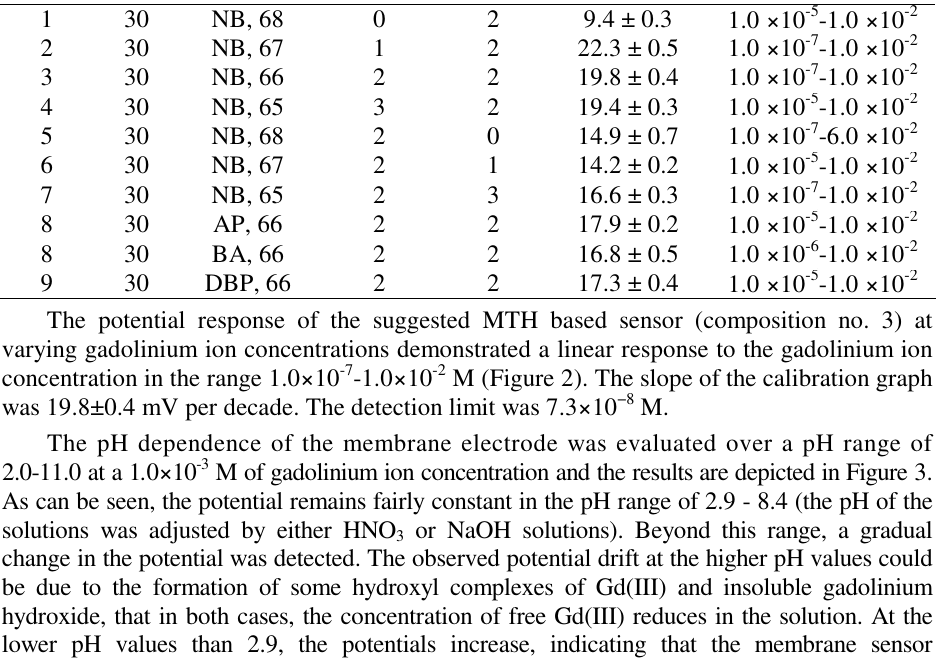
Figure 3. pH effect of the test solution (1.0 × 10 -3 M of Gd 3+ ) on the